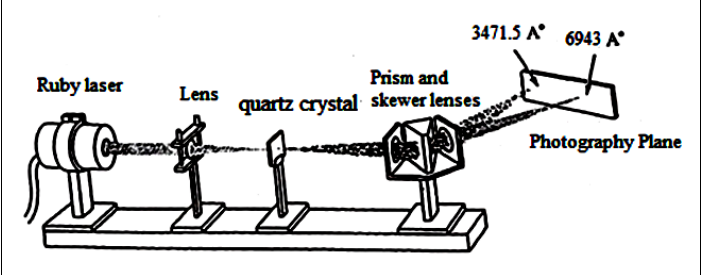
Figure 1. Generation of the second harmonic beam by nonlinear materials